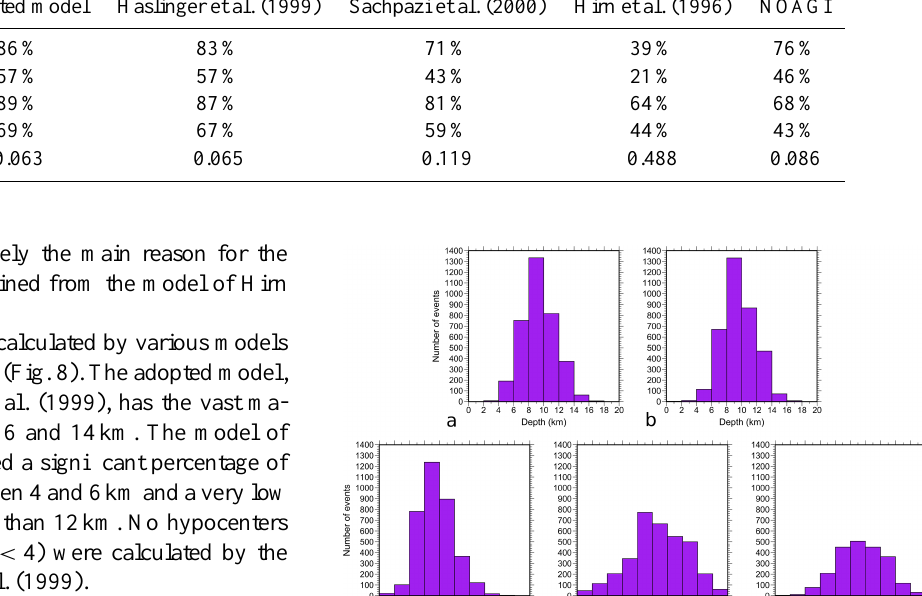
Table 2. Distribution of horizontal (ERH) and vertical (ERZ) uncertainties for the events relocated with several seismic velocity models. Performance